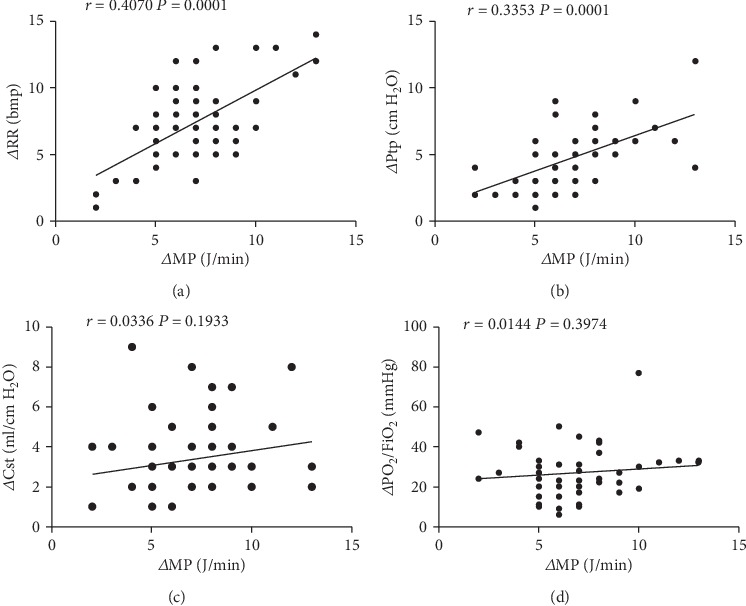
Correlation between ΔMP and ΔRR, ΔPtp, ΔCst, and ΔPF. (a) ΔMP vs. ΔRR. (b) ΔMP vs. ΔPtp. (c) ΔMP vs. vs. ΔCst. (d) ΔMP vs. ΔPF. Results were expressed as mean ± standard deviation (x ± s) of at least three different measurements.